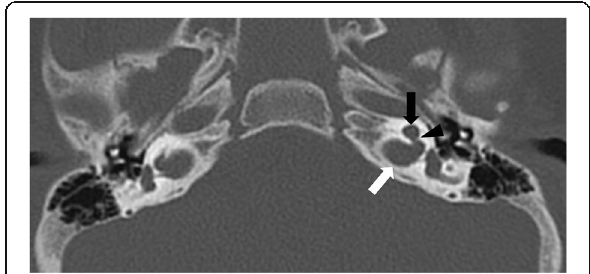
Fig. 1 Computed tomography image of the temporal bone of a patient with HDR mimicking a congenital X-linked stapes gusher syndrome. Axial CT section of the temporal bones shows severe cochlear hypoplasia ( black arrow ), bulbous dilatation of the fundi of the IAC (white arrow) and a fistulous connection between the internal auditory canal and the cochlear basal turn with absence of the bony partitions ( black arrowhead ) on the left. These findings were seen on the right side (not shown)IAC; Internal Auditory